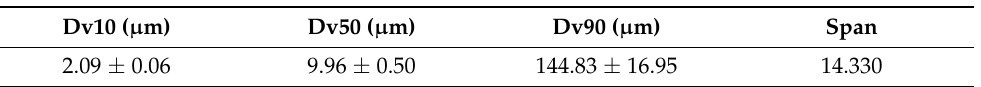
Table 2. Particle distribution values of the aerosol cloud from AZT MPs by Spraytec ® , (mean ± SD, n =